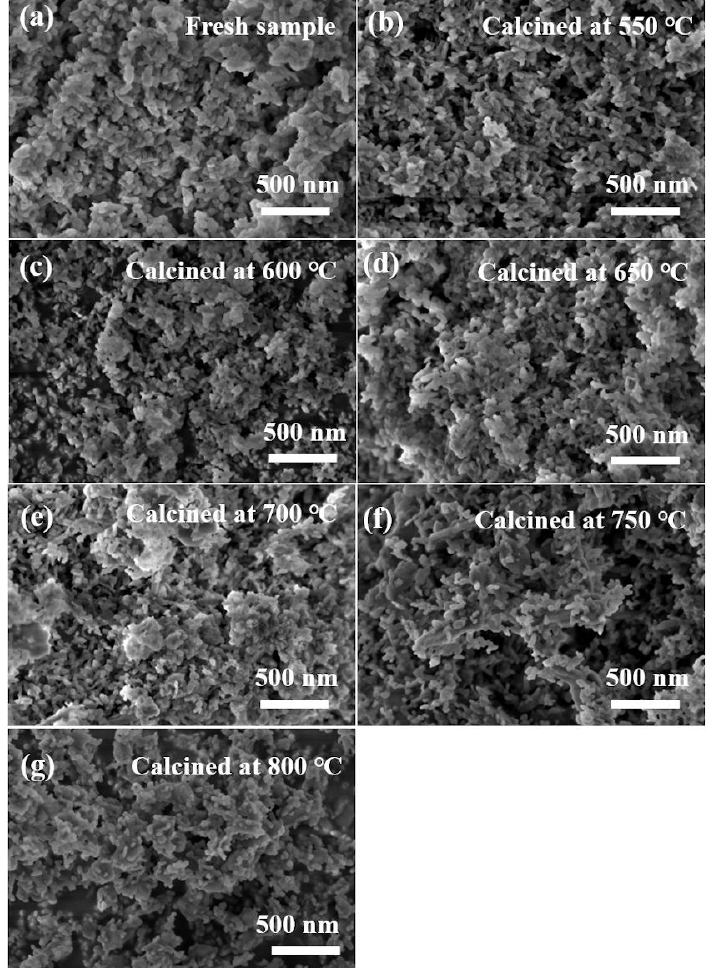
Figure 2. SEM images of Ca–Mg–Al layered double hydroxides calcined at different temperatures: ( a ) fresh sample; ( b ) calcined at 550 °C; ( c ) calcined at 600 °C; ( d ) calcined at 650 °C; ( e ) calcined at 700 ( a ) fresh sample; ( b ) calcined at 550 ◦ C; ( c ) calcined at 600 ◦ C; ( d ) calcined at 650 ◦ C; ( e ) calcined at °C; ( f ) calcined at 750 °C; ( g ) calcined at 800 °C. 700 ◦ C; ( f ) calcined at 750 ◦ C; ( g ) calcined at 800 ◦